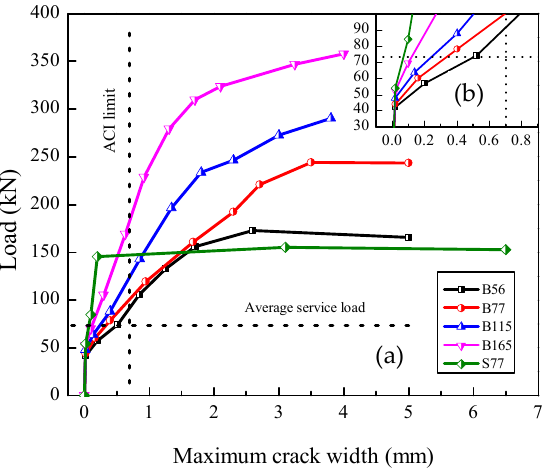
Figure 8. ( a ) Load-maximum crack width curves; ( b ) Load-maximum crack width under service load.